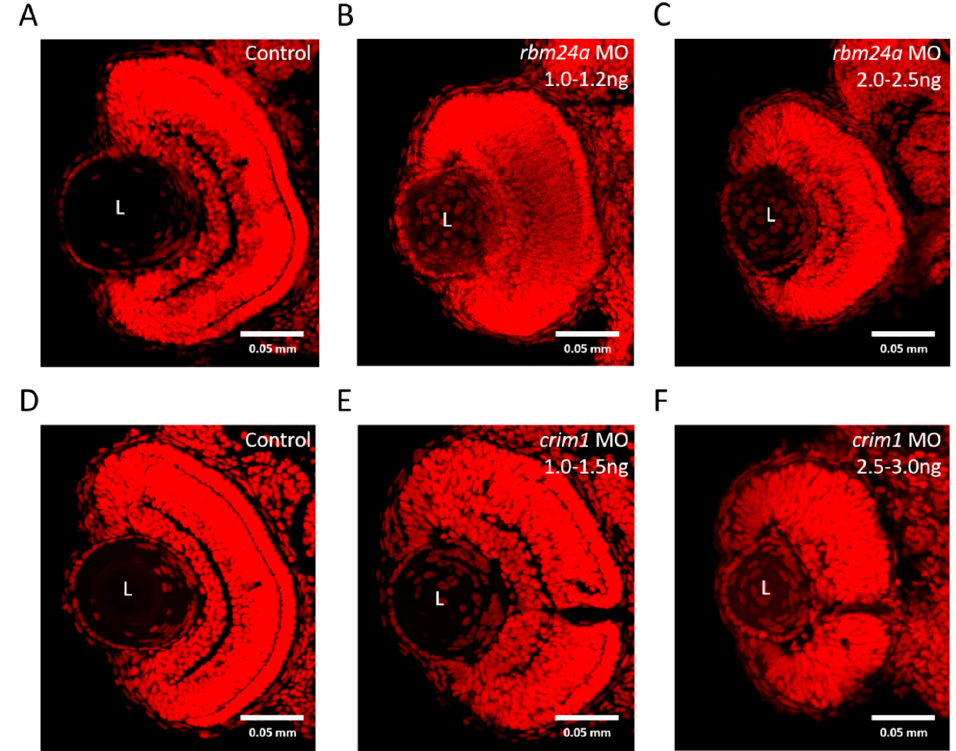
Figure 7. rbm24a and crim1 morphants have congenital eye defects. ( A ) Control; ( B ) rbm24a AUG MO 1.0–1.2 ng; ( C ) rbm24a AUG MO 2.0–2.5 ng; ( D ) control; ( E ) crim1 AUG MO 1.0–1.5 ng, and ( F ) crim1 AUG MO 2.5–3.0 ng. L denotes the lens. Scale: 0.05 mm. TOPRO3-stained nuclei appear red.